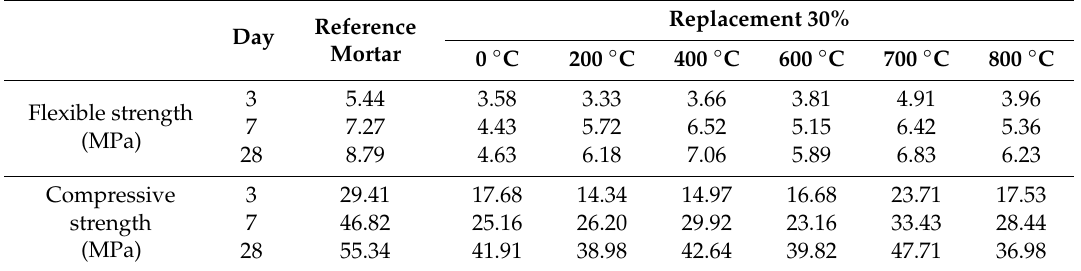
Table 4. Mechanical strengths of mortars with the heated WCP for replacing 30% cement.